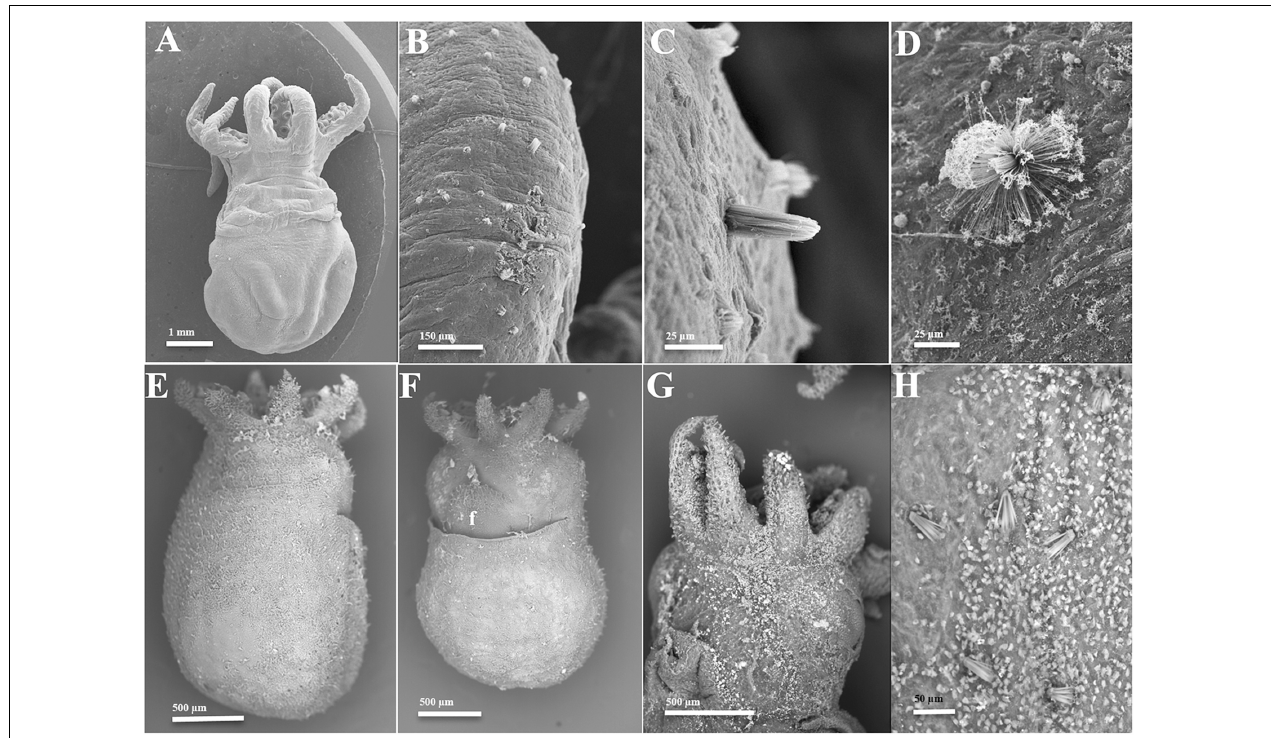
FIGURE 5 | Scanning Electron Microscopy images of (A–D) Amphioctopus fangsiao (5 days, ML 3.2 mm); (E,F) Robsonella fontaniana (two individuals, both 0 day, ML 1.9 mm) and (G,H) Pinnoctopus cordiformis (two individuals, both 0 day, 2.6 mm ML). (A) Dorsal view; (B) initially erupted and semi-erupted KO on right arm I; (C) KO erupted on left arm I; (D) everted KO on dorsal mantle; (E) dorsal view; (F) ventral view. Note density of erupted KO on distal funnel (f); (G) , ventral view; (H) everted KO on ventral